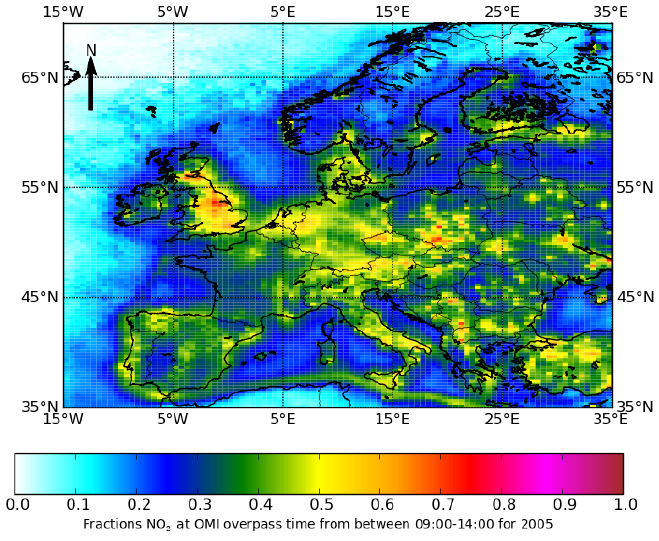
Figure 7. Sensitivity of the modeled OMI-NO 14:00 local